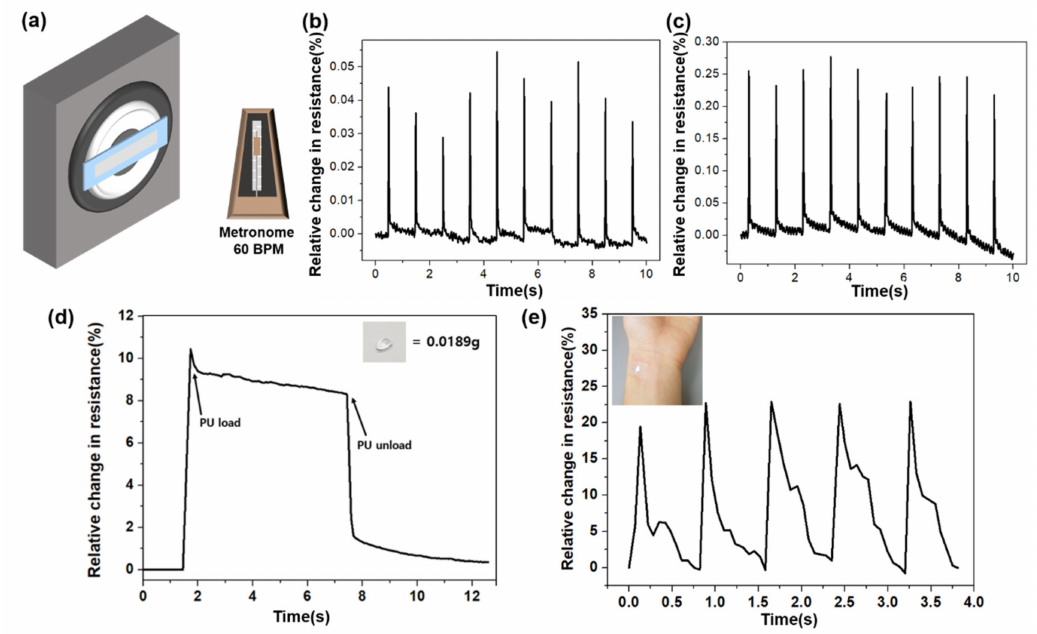
Figure 6. ( a ) Schematic of the sensor attached on a speaker, generating 60 BPM metronome. ( b – c ) Di ff erence in the relative resistance change between with and without the hybrid process. ( d ) Relative resistance change when PU bead loading and unloading. ( e ) Relative resistance change of the pulse signal (inlet: photograph of the attached spot).